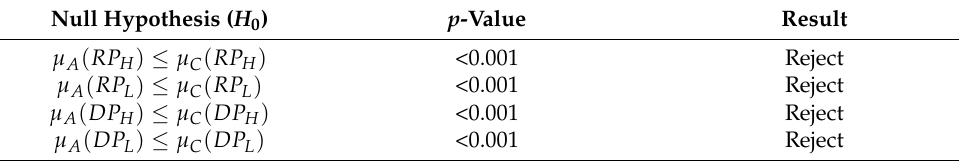
Table 5. Statistical test results for Scenario A and Scenario C